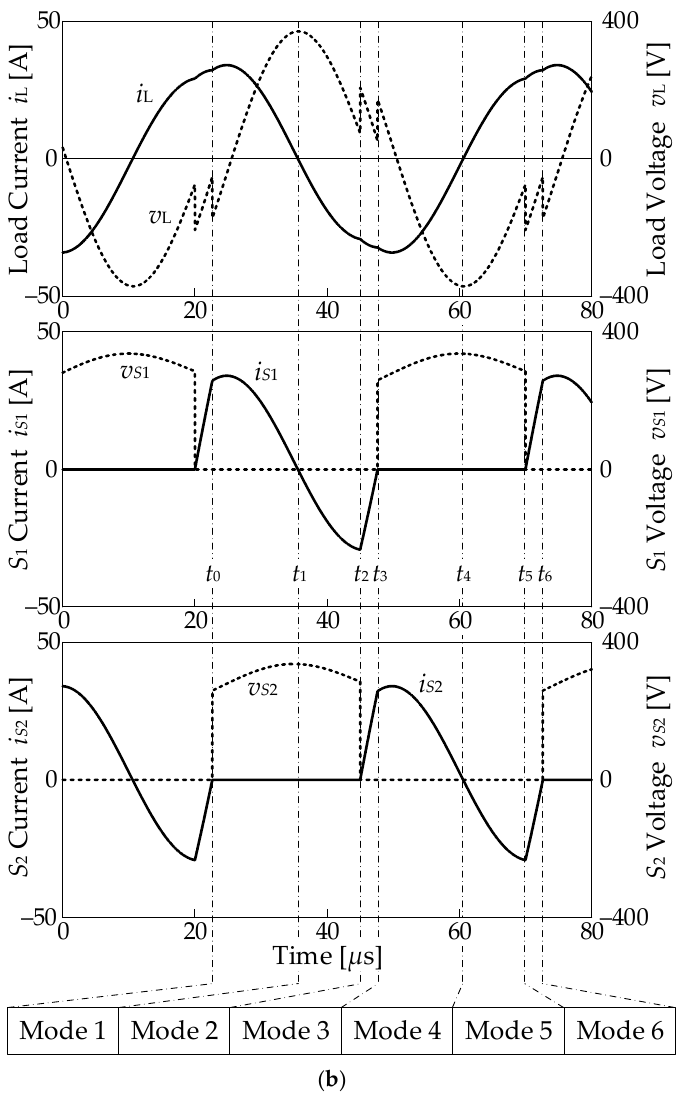
Figure 5. Operating conditions. ( a ) Circuit mode transitions. ( b ) Operating waveforms by sim- ulations.